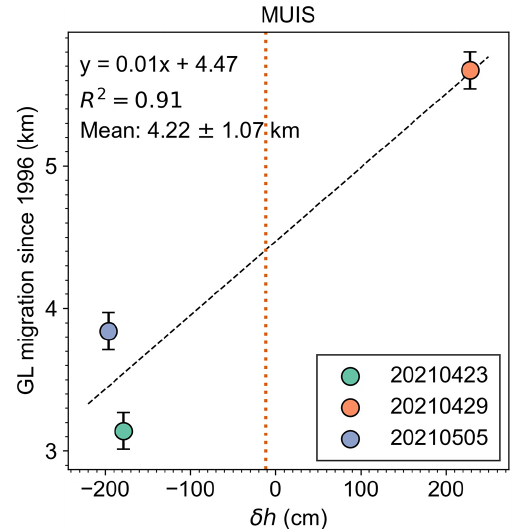
Figure 3. Correlation between the differential tidal predictions from the CATS2008 tidal model at the acquisition dates of each interfer- ogram and the grounding line (GL) migrations from 1996 for the three Sentinel-1a/b DInSAR interferograms in Fig. 2d–f (Table S1). The GL migration is measured along the ice flowline (white solid line in Fig. 2d–f). Positive GL migration values indicate that the GL retreated inland with respect to the reference point, which is the intersection between the 1996 DInSAR-derived GL (Rignot et al., 2011, 2016) and the ice flowline. The vertical orange dotted line de- notes the differential tidal amplitude calculated from the CATS2008 tidal model at the time of four satellite image passes used in the MEaSUREs 1996 ERS-1/2 DInSAR GL measurement (Rignot et al., 2011, 2016) (Table S2). The geolocation of the tidal prediction reference point is shown in Fig.